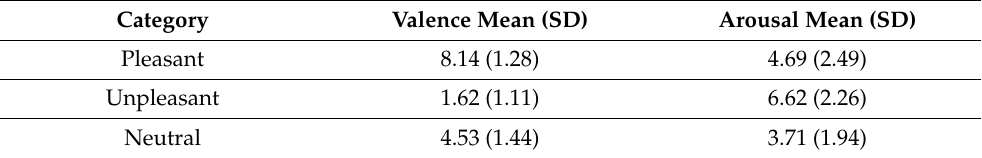
Table 2. IAPS image valence means and standard deviations.